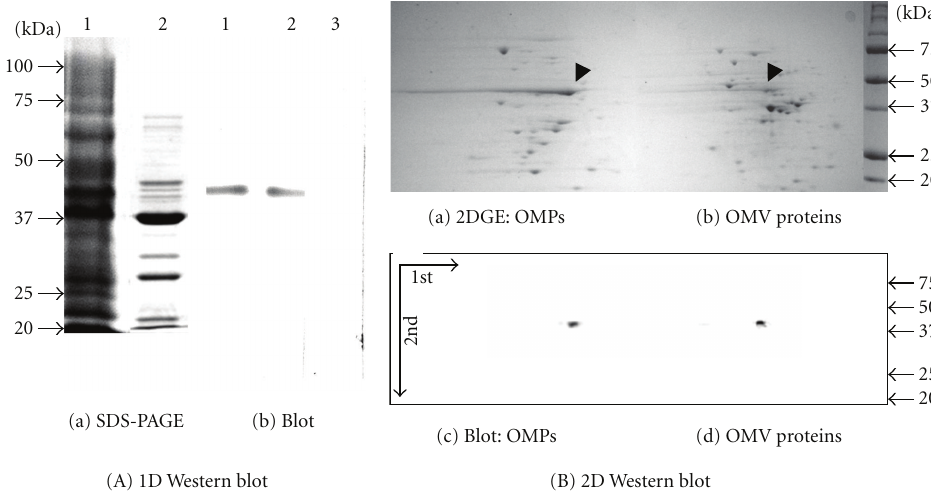
Figure 3: EF-Tu detected in OMV and OM fractions. Panel (A): (a) SDS-PAGE of proteins from OM (lane 1) and OMV fractions (2). (b) Western blot of proteins from OM (lane 1) and OMV fractions (2) reacted with the EF-Tu antibody diluted at 1:3000. Control blot with pre-immune serum (lane 3). Panel (B): 2D-based Western blot. Proteins from OM (a and c) and OMV fractions (b and d) were resolved by isoelectric focusing (1st D) and then separated on a second dimension SDS-PAGE (2nd D). Proteins from the gel were blotted onto PVDF membranes and probed with the anti-EF-Tu antibodies (c and d). Arrows: EF-Tu. Blot with pre-immune serum not shown.